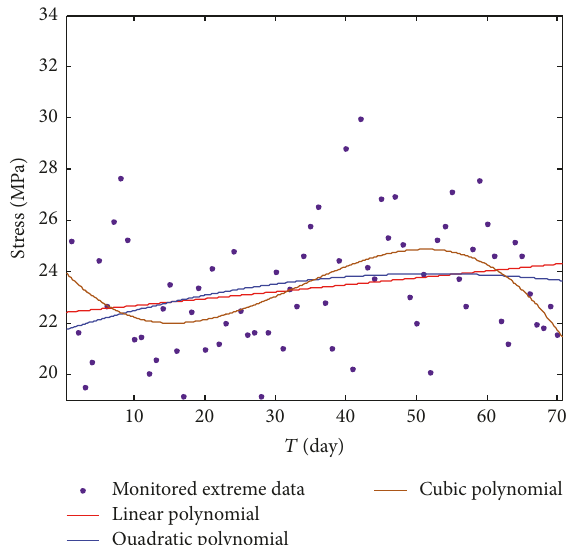
Figure 6: Monitored data and its regression analysis.